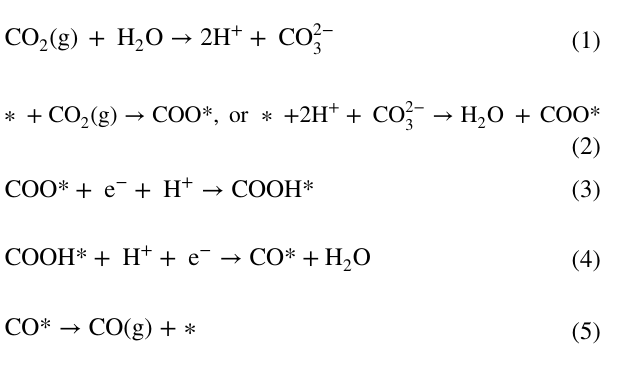
N for the CO 3 4 2